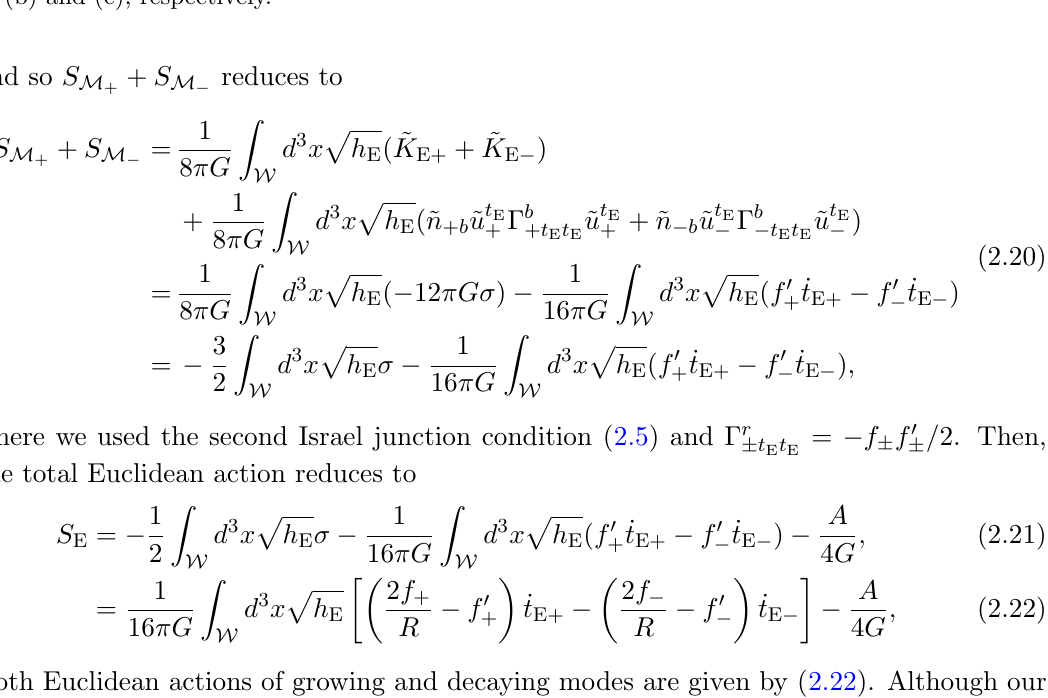
Figure 3 . Schematic pictures of analytic continuation between the Lorentzian and Euclidean solutions for (a) O (4) bounce and (b,c) O (3) bounce. The growing and decaying modes are shown in (b) and (c),